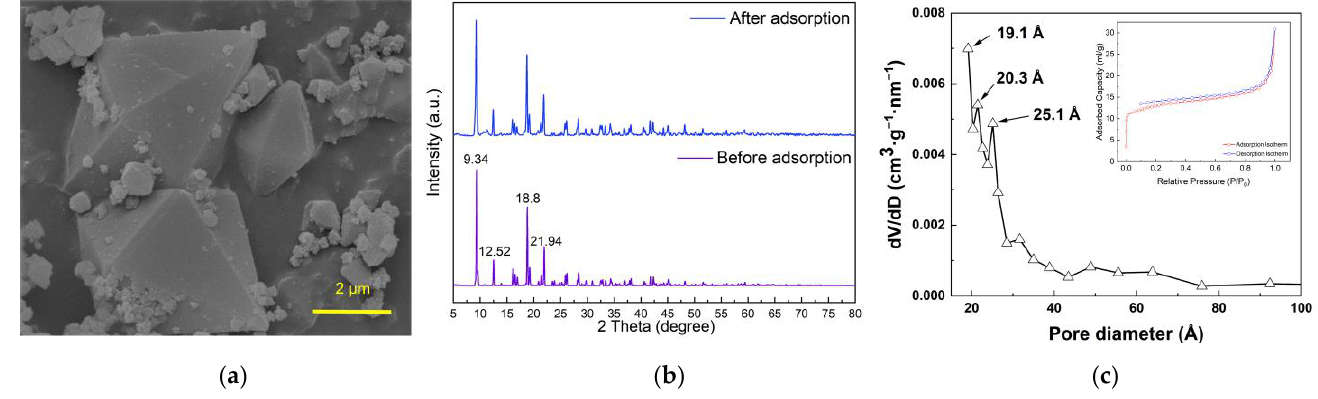
Figure 1. ( a ) SEM image of MIL-101(Fe); ( b ) X-ray diffraction curve of MIL-101(Fe) before and after adsorption; ( c ) PSD and BET isotherm of MIL-101(Fe).